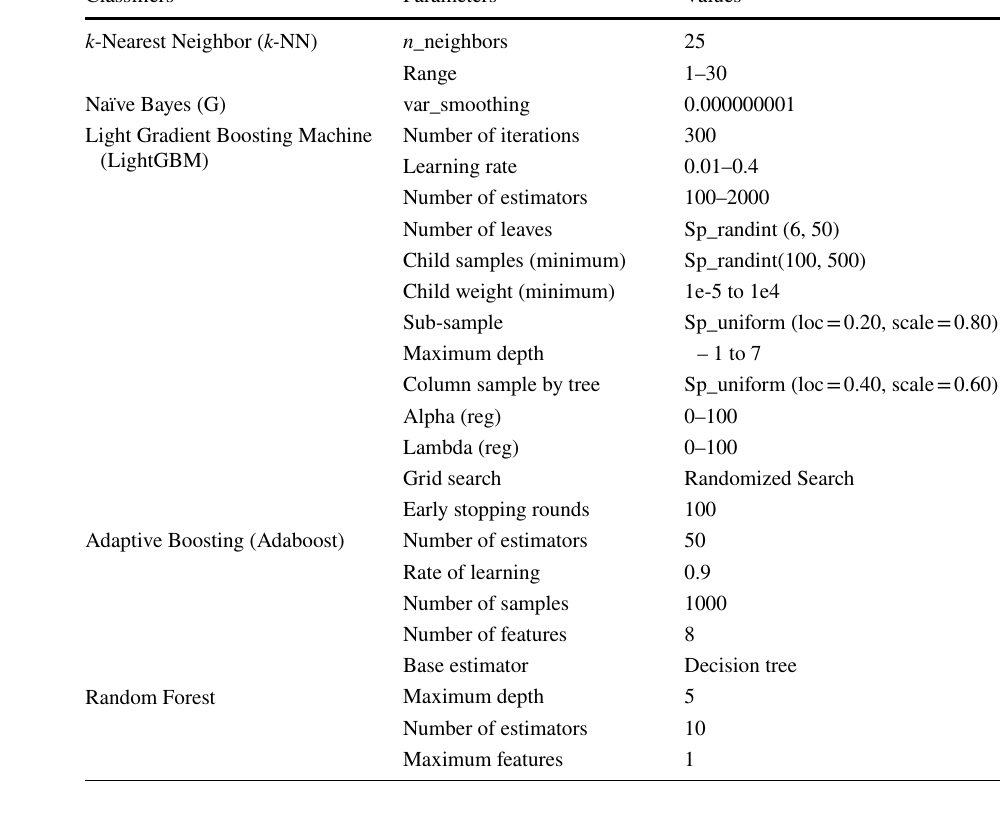
Table 5 Classifier’s parameters and input values